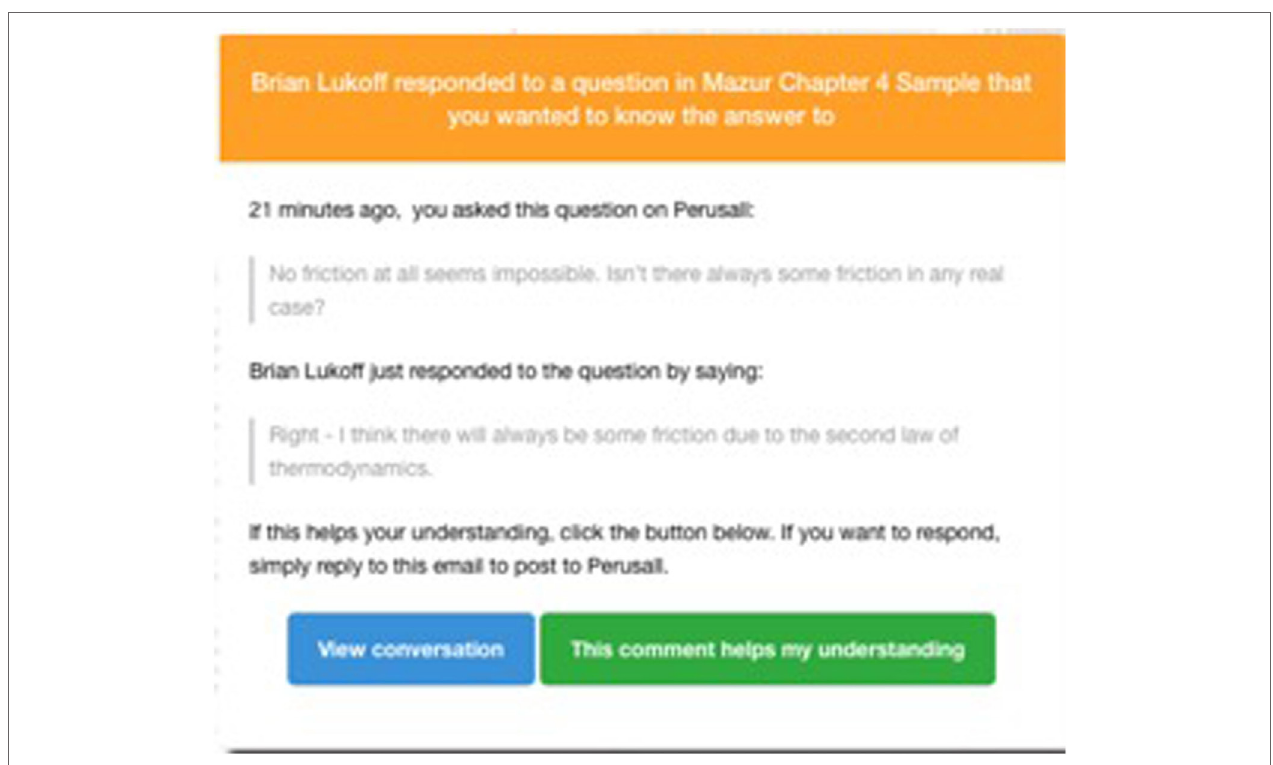
FigUre 6 | Email notification from